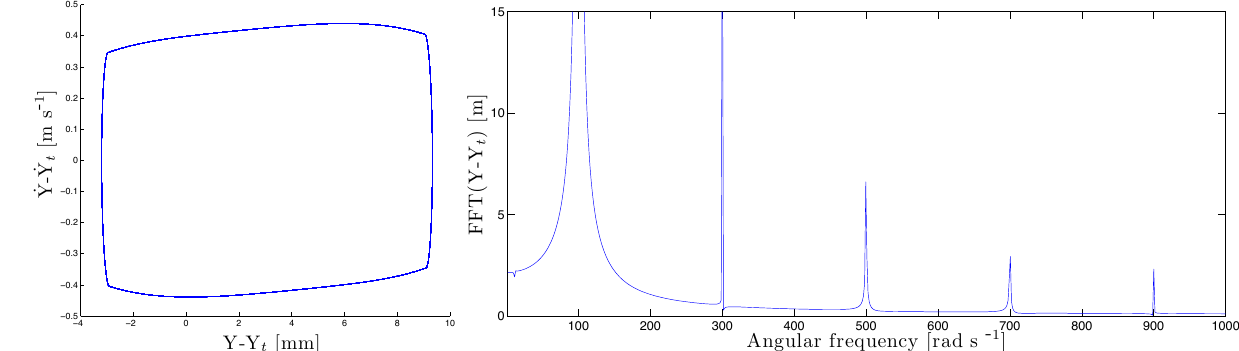
Fig. 15 Phase portrait (left), Y − Y t versus ˙Y − ˙Y t and Fourier spectra (right) for the angular frequency ω = 100 rad s − 1 and the gaps between the rotor frame and the impact element c 1 = c 2 = 6 mm.